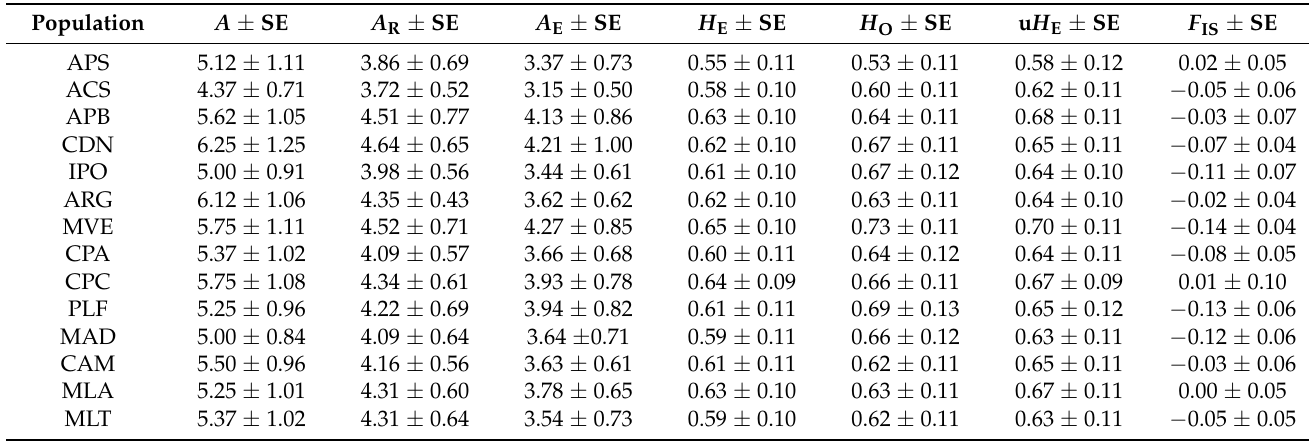
Table 2. Summary statistics of within-population genetic variation averaged over loci. Populations are abbreviated as in Figure 1. A : number of alleles; A R : allelic richness; A E : number of effective alleles; H E : expected heterozygosity; H O : observed heterozygosity; u H E : unbiased expected heterozygosity; F IS = inbreeding coefficient; SE: Standard